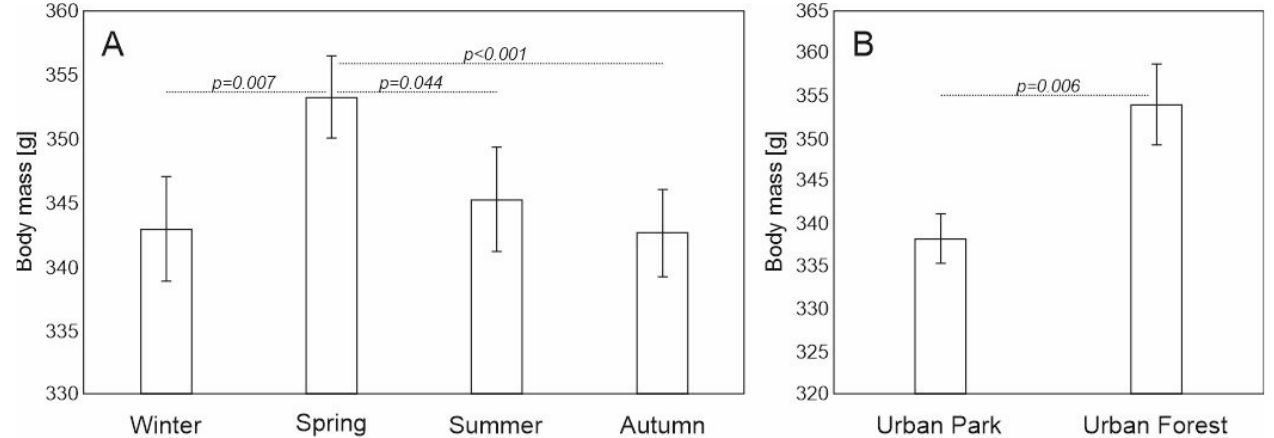
Figure 4. Mean (±SE) body mass of adult red squirrels with regard to ( A ) season and ( B ) study site, and pairwise comparison with Least Significant Difference test in LMM (significant differences pre- sented above the bars). Please note that Y axis does not start from 0 value.